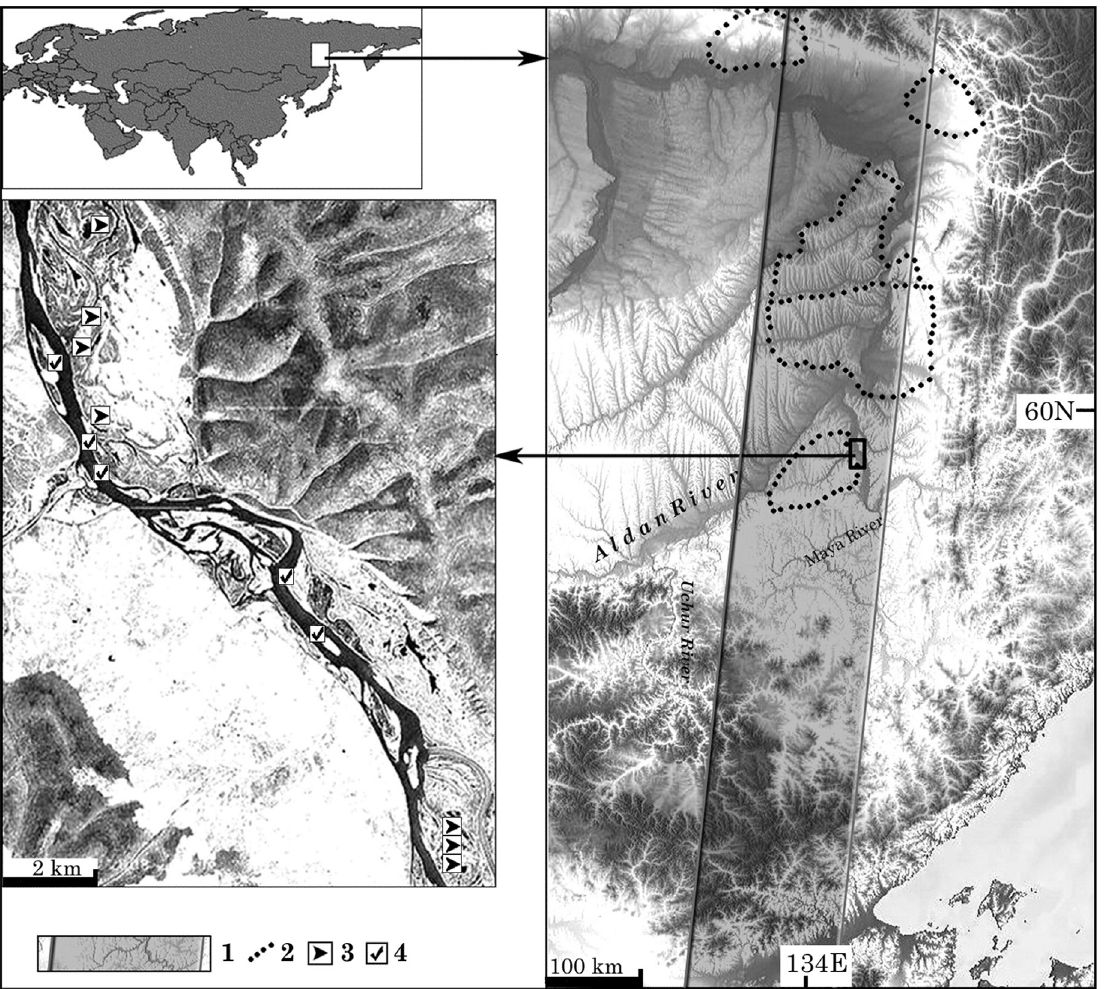
Figure 1. Study area. 1 - Flyway; 2 - Boundaries of local nature reserves; 3 - Location of spring stopovers; 4 - Location of autumn